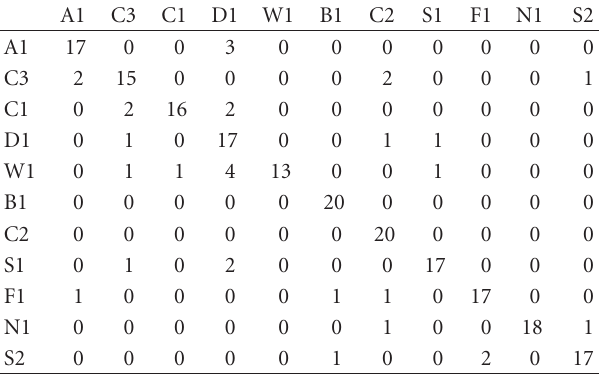
Table 1: Class-confusion matrix for trimmed classification tree (correlogram).